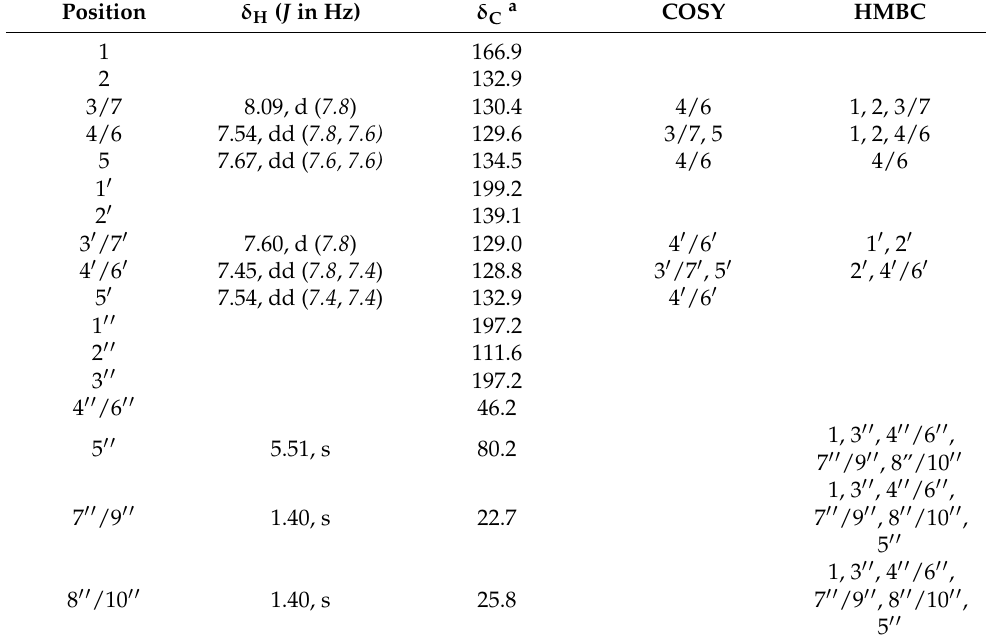
Table 1. NMR data (600 MHz, CD 3 OD) for Tristaenone A ( 1 ).